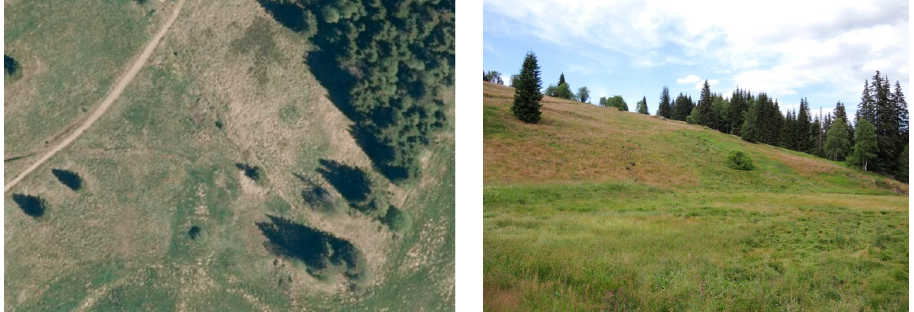
Figure A6. Aerial photo and photo of class C1.